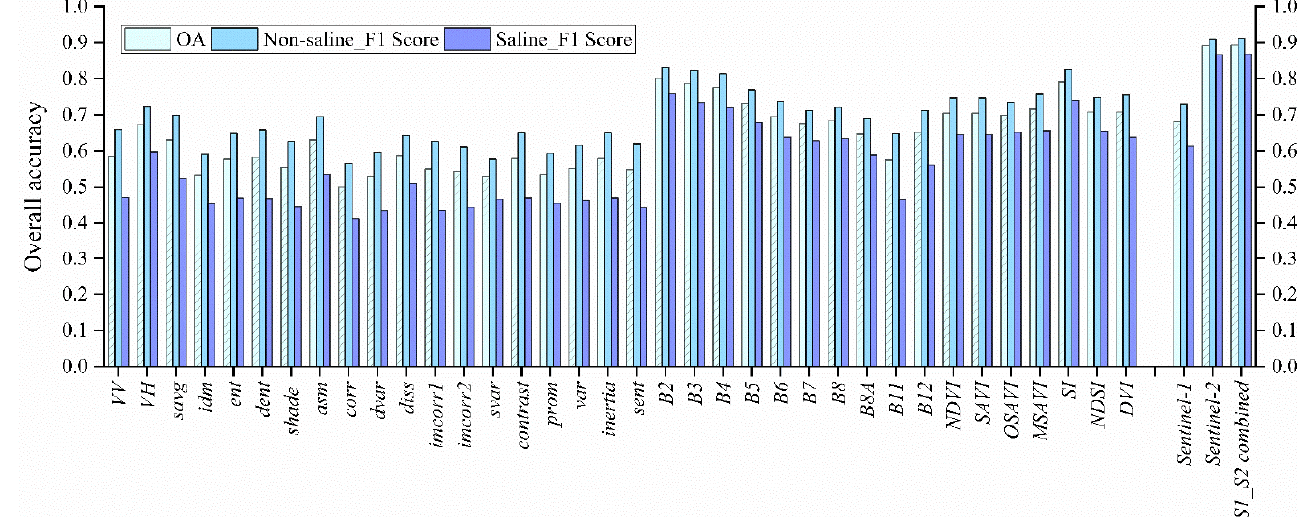
Figure 5. Classification accuracies of each variable and the combined datasets: Sentinel-1 indicates the mean value of Sentinel-1 dual-PolSAR (VV + VH) bands; Sentinel-2 suggests the combination of texture and indices derived from reflectance bands of Sentinel-2 and original mean values of spectral bands. S1_S2 combined indicates the combination of Sentinel-1 and Sentinel-2 datasets.